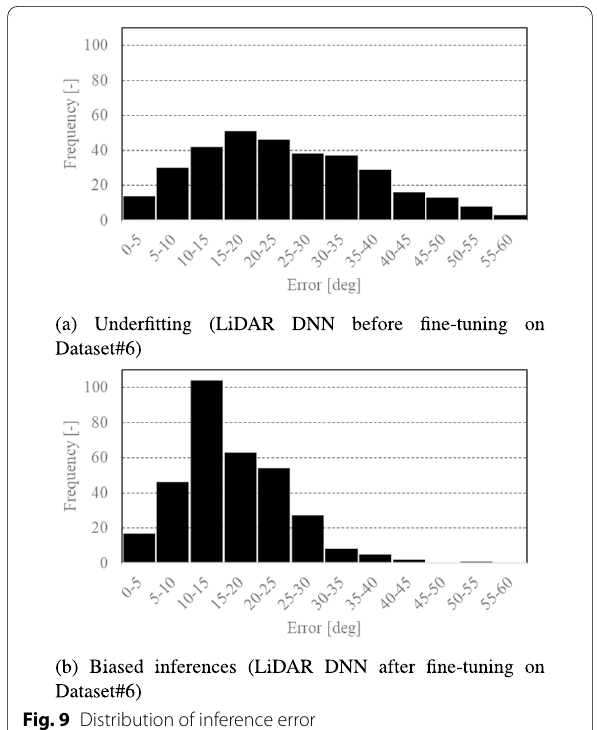
Fig. 9 Distribution of inference error